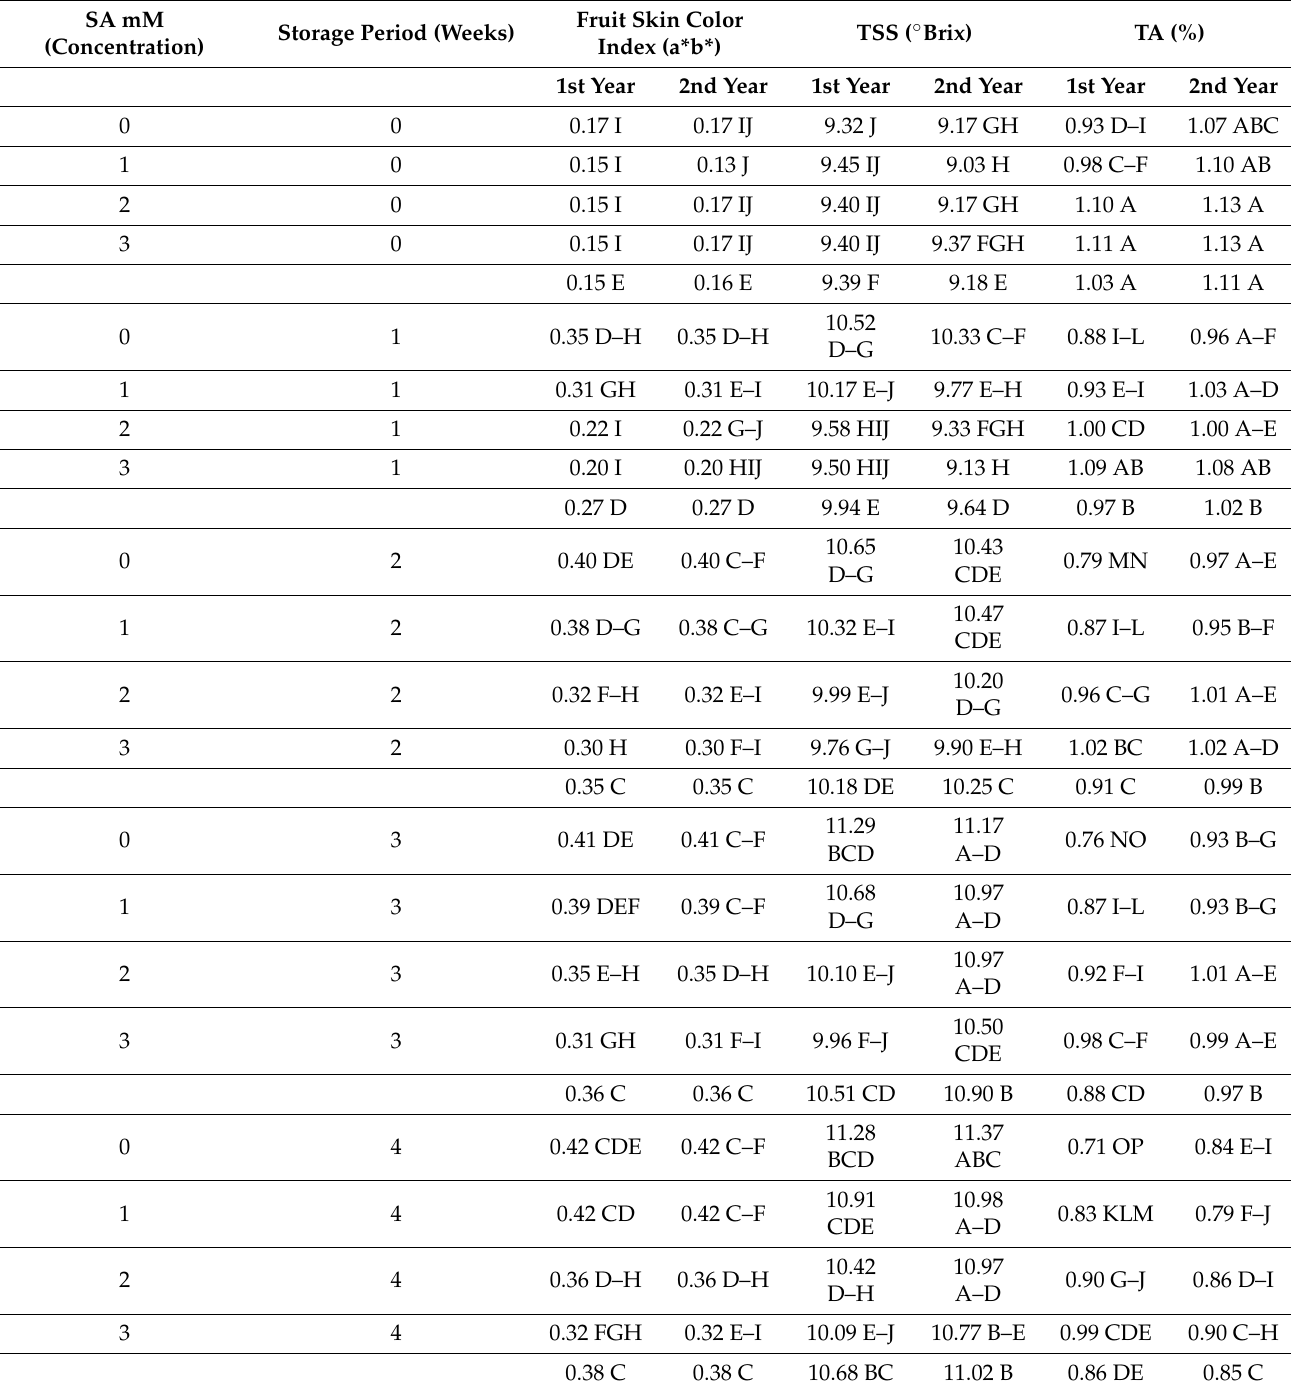
Table 4. Effect of different pre-harvest treatments of SA on the peach fruit physicochemical characteristics during low- temperature